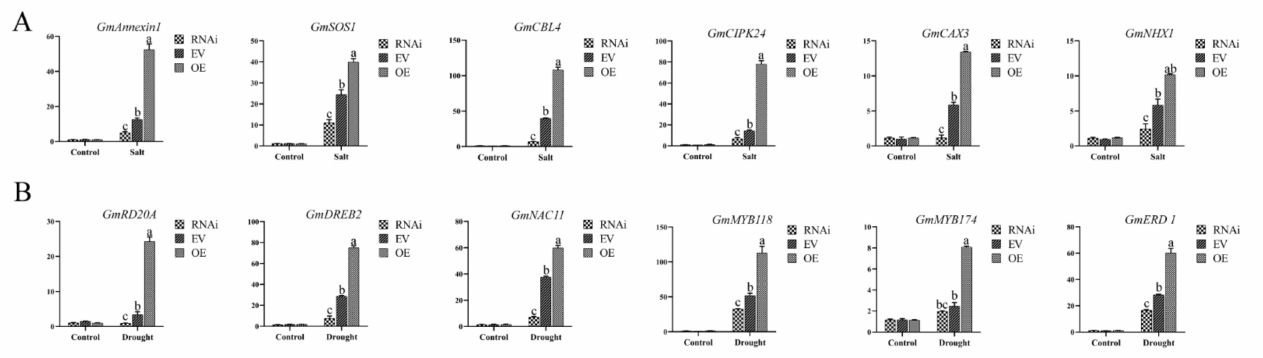
Figure 9. The expression levels of stress-responsive gene in transgenic soybean hairy roots. ( A ) The expression levels of salt-responsive genes under salt stress in transgenic soybean hairy root. ( B ) The expression levels of drought-responsive genes under drought stress in transgenic soybean hairy root. Three biological replicates were performed, and the values are means ± SD. Values marked with similar letters indicate not statistically significant differences (Student’s t -test: p ≤